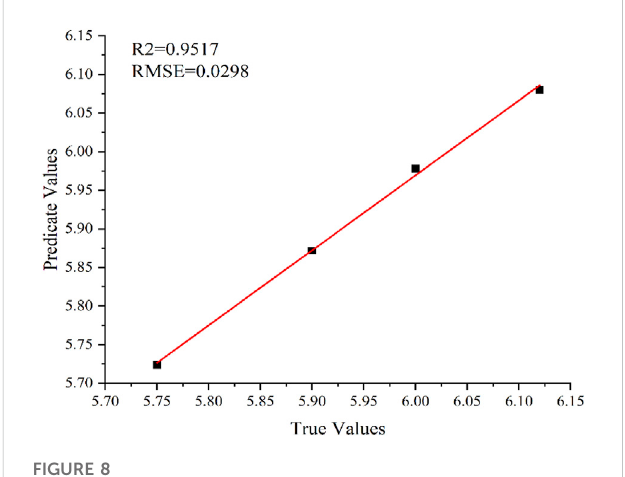
FIGURE 8 Prediction results using RF model for pH.